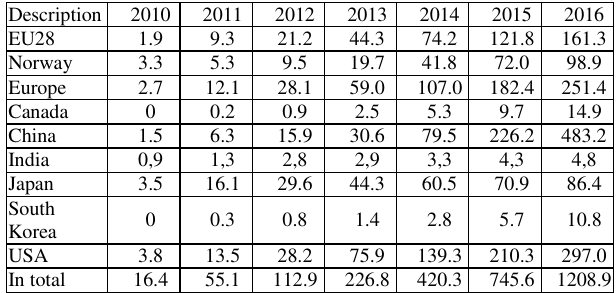
Table 2. Registered fleet of passenger BEVs in years 2010-2016, in thousands [8]